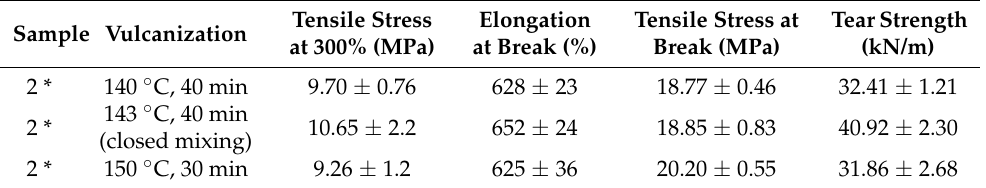
Table 4. Mechanical properties of fiber/NR composites vulcanized under different conditions.